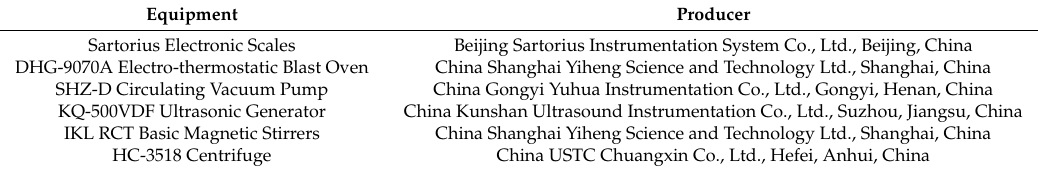
Table 2. List of